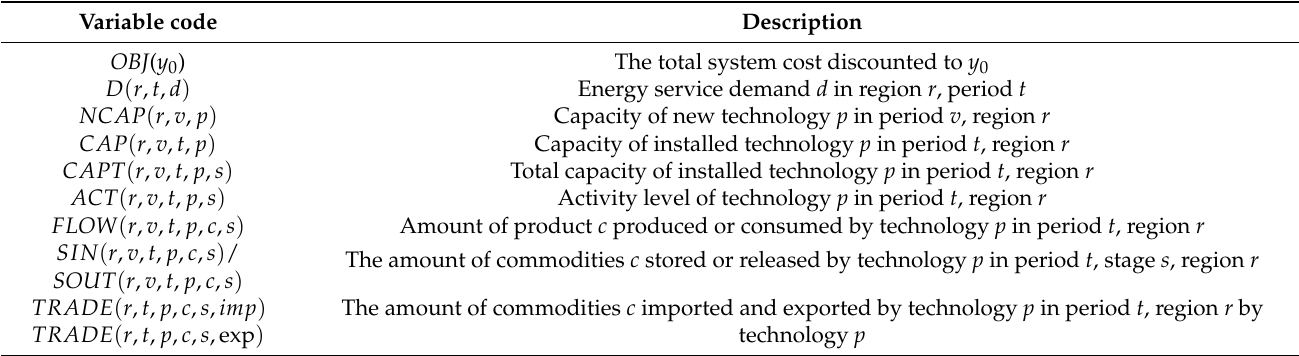
Figure 2. Multi-pollutant Abatement Planning and Long-term benefit Evaluation (MAPLE) integrated assessment frame- work. Table 1. Decision variables and Table 1. Decision variables and descriptions.